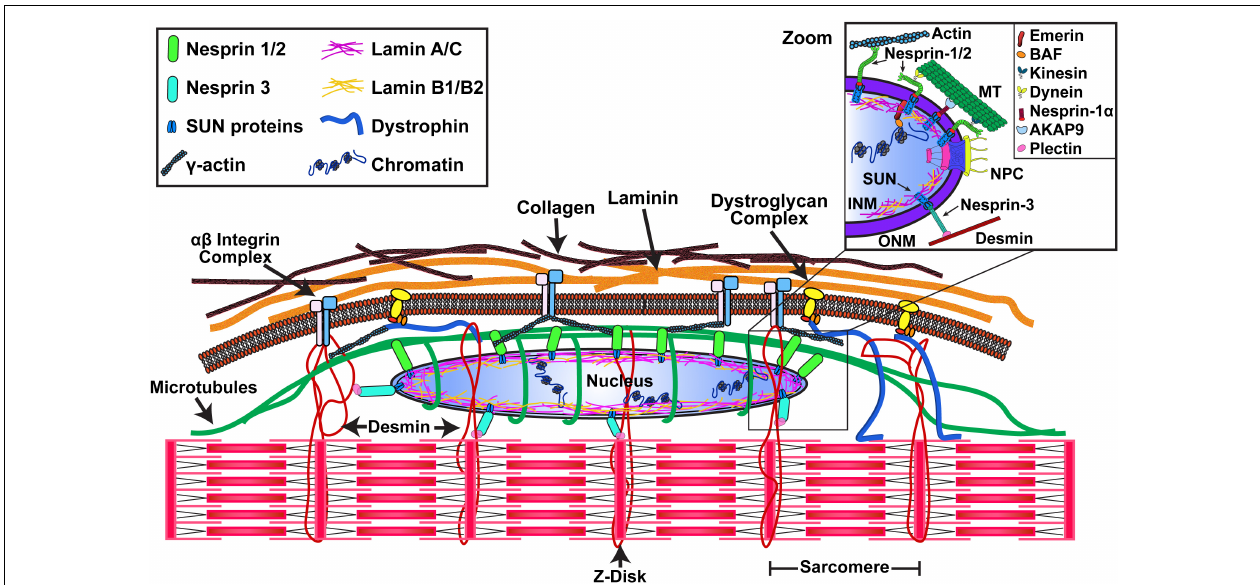
FIGURE 1 | Cytoskeletal organization around myonuclei provides a mechanism for nuclear mechanotransduction. Cytoskeletal proteins (microtubules, desmin, and γ -actin) are directly connected to myonuclei via the LINC (Linker of Nucleus and Cytoskeleton) complex. The LINC complex is composed of nesprin and SUN proteins, with SUN proteins interacting with the nuclear lamina (composed of A- and B-type lamins). Chromatin is tethered to the periphery of the nucleus via the nuclear lamina, providing a mechanism for cytoskeletal mechanical signals to be transmitted directly to the nuclear interior and chromatin. Inset: The SUN components of the LINC complex interact with NPCs. Emerin binds to the nuclear lamina and the chromatin-interacting protein BAF. The giant isoforms of Nesprin-1/2 interact with actin through their CH domain and microtubules via kinesin-1 and dynein (Zhu et al., 2017), while Nesprin-1 α uses AKAP9. Nesprin-3 binds to desmin via plectin. Modified from Kirby